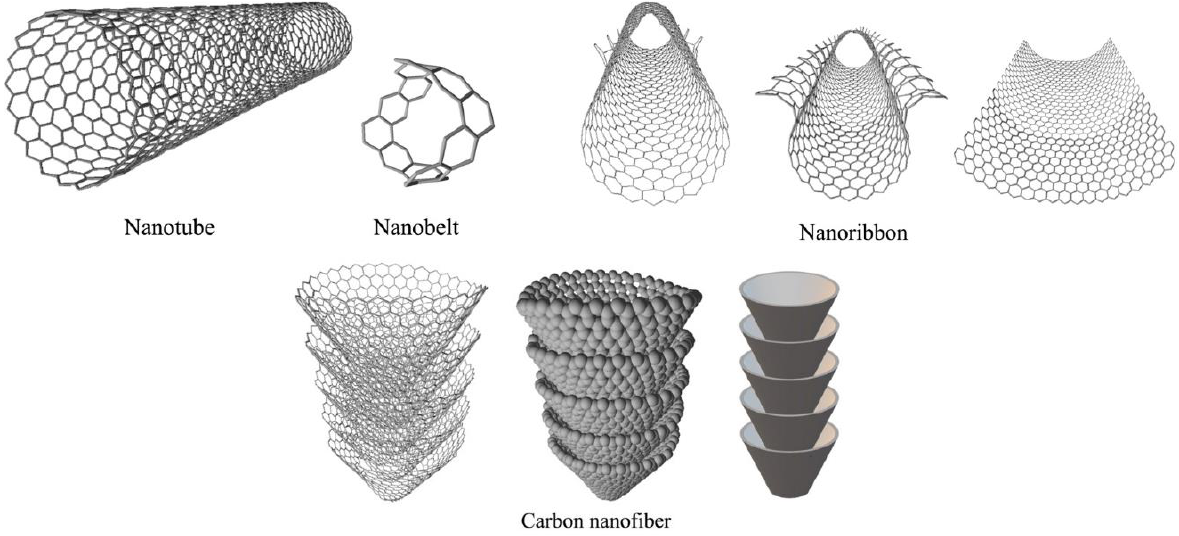
Figure 2. Different structures of nanotubes, nano ribbons, nano belts, and carbon nano fibers [1].